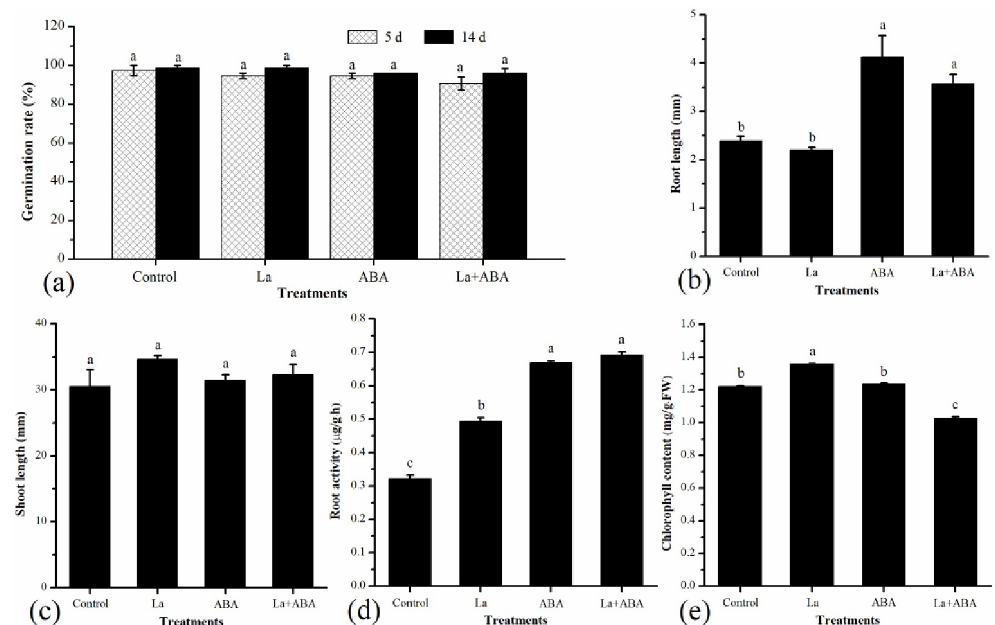
Fig 1. Effects of La and ABA treatments on seed germination and seedling growth in switchgrass. (a) germination rate, (b) root length, (c) shoot length, (d) root activity, (e) chlorophyll content. Note: Means of treatments followed by different letters are significantly different at P <